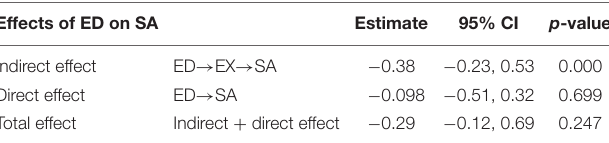
TABLE 2 | Mediation of the association between emotional dissonance (ED) and sickness absence (SA) through exhaustion (EX). Effects of ED on SA Estimate